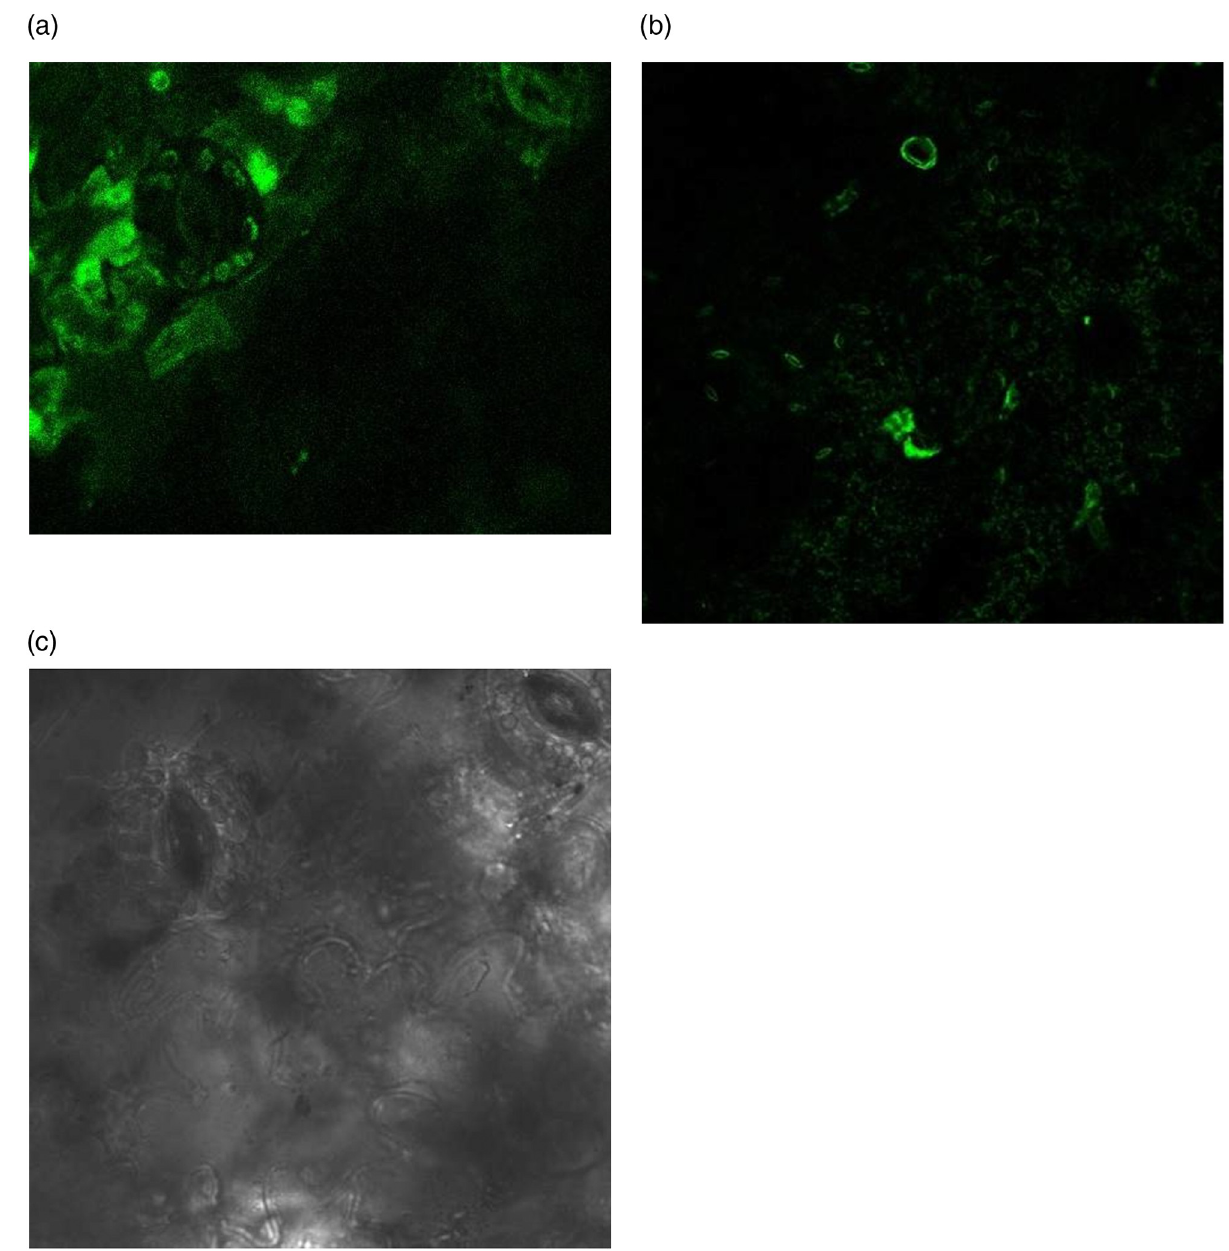
Fig 2. GFP visualization through confocal microscope A, B: Leaves transformed with GFP , C: Control leaves without GFP . tumefacians strain EHA105. The transformed A . tumefacians EHA105 were maintained on culture medium separately for transformation of stevia leaves with individual SrKO and SrUGT76G1 and mixed in 1:1 ratio to co-transform stevia leaves with both SrKO and SrUGT76G1 cDNA. Transient transformation of the leaves was confirmed by the amplifying genomes of stevia using CAMV-35S/ SrKO and CAMV-35S/ SrUGT76G1 specific primers. Co- transformation of stevia leaves with SrKO and SrUGT76G1 was also confirmed by presence of both the amplicons of 150bp and 200bp, respectively in the genome of stevia (Fig 3). HPTLC